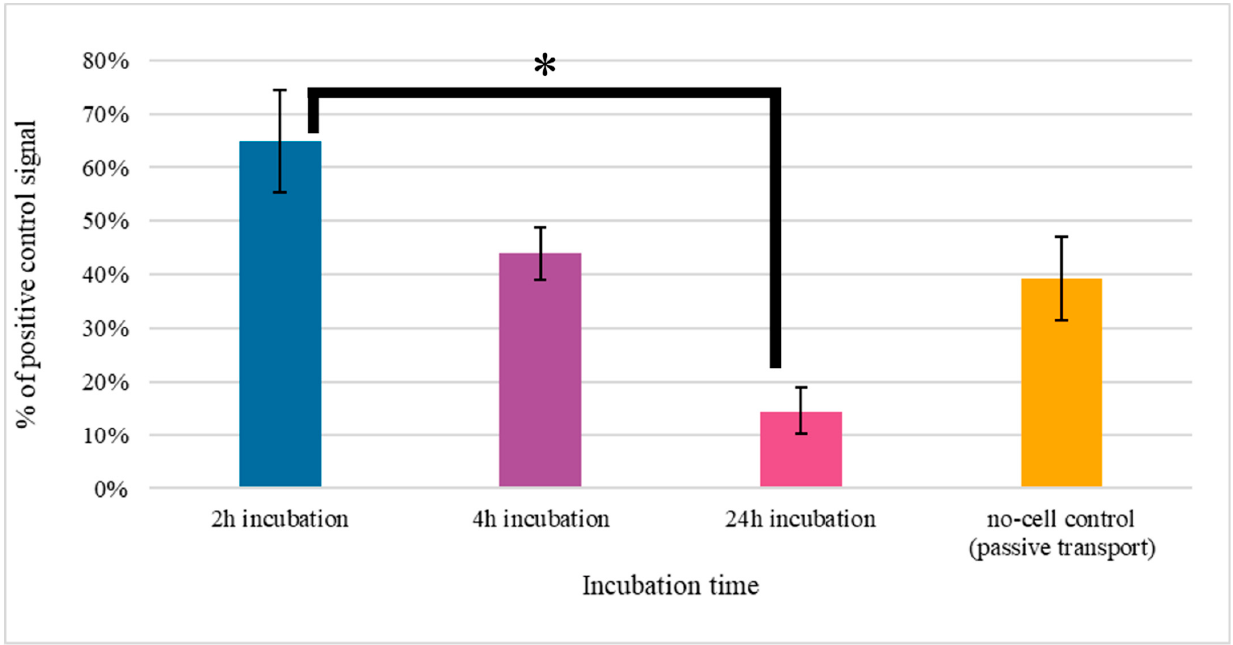
Figure 9. Transition experimental results obtained with hCMEC/D3 cells. Errors were estimated using the standard deviation calculated from repeats. Before the test, the integrity of the monolayer was checked, and the test was conducted only if the TEER factor indicated the existence of a monolayer. * p -value ≤ 0.05.